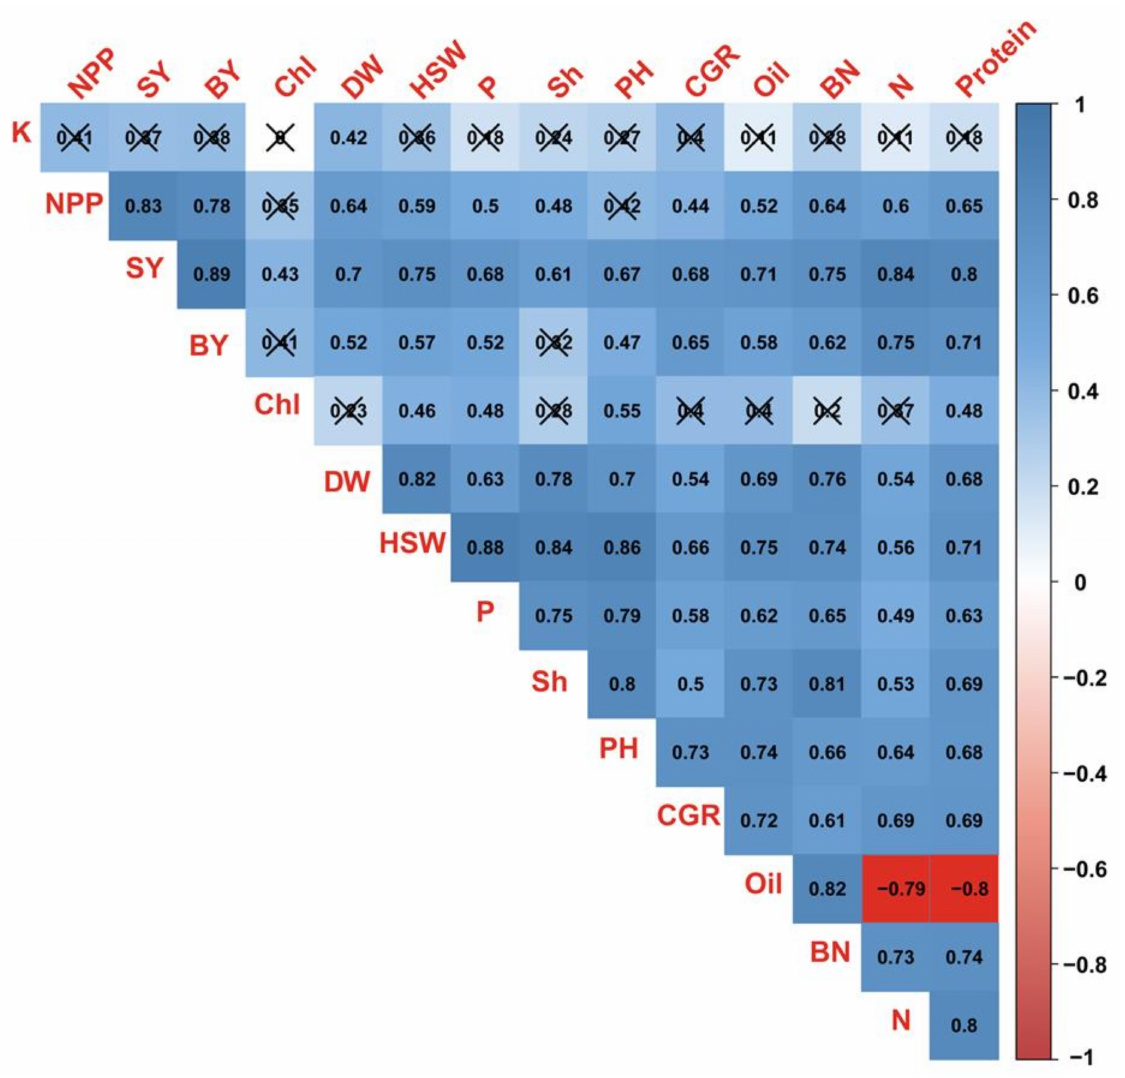
Figure 3. Pearson’s correlation coefficients among 15 studied traits under different fertilizer combina- tions (combined analysis of two successive seasons, 2020 and 2021). NPP, number of pods/plant; Sh, shelling; HSW, 100-seed weight; BY, biological yield; SY, seed yield; N, nitrogen; P, phosphorous; K, potassium; BN, branching number; PH, plant height; DW, dry weight; CGR, crop growth rate. Blue indicates positive correlation, while red indicates negative correlation. Crossed cells with (X) symbol indicate statistically non-significant correlations ( p ≥